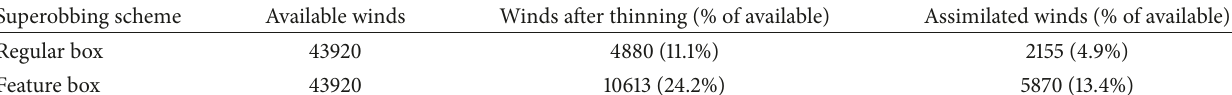
Table 3: Typical number of winds available, after thinning and assimilating in the experiment.